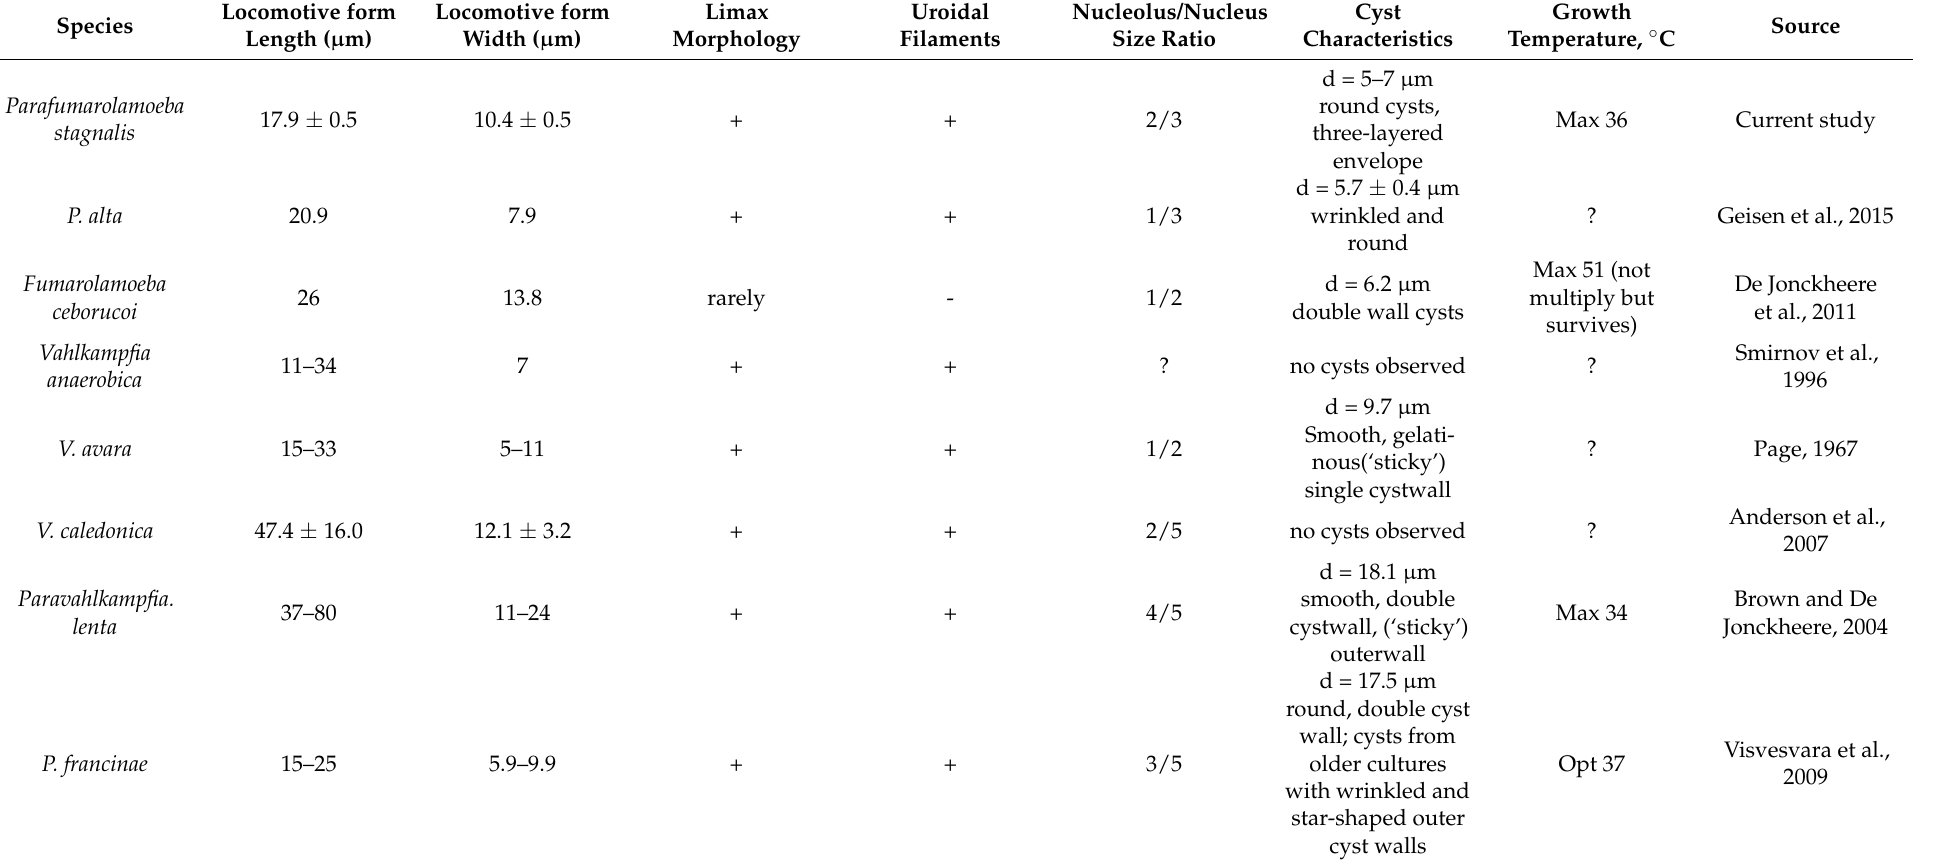
Table 1. Morphological comparison of P. stagnalis and related species